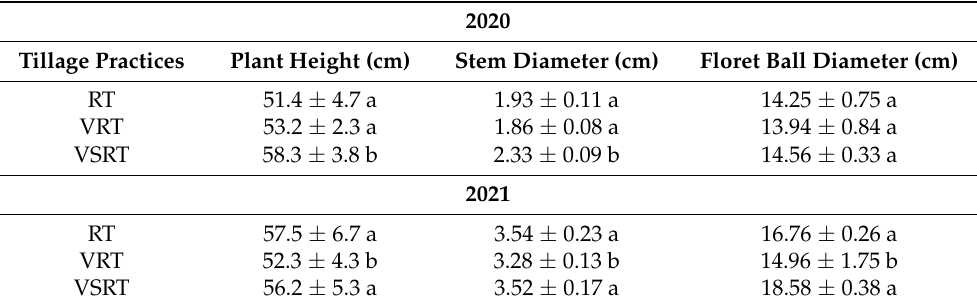
Figure 6. Dynamic changes of root elongation and dry matter accumulation (DMA) of broccoli under the three tillage methods in 2020 ( a , c ) and 2021 ( b , d ). Rotary tillage, RT; vertical rotary tillage, VRT; vertical smashing rotary tillage, VSRT. Table 2. Characteristics of broccoli under the three tillage practices in 2020 and